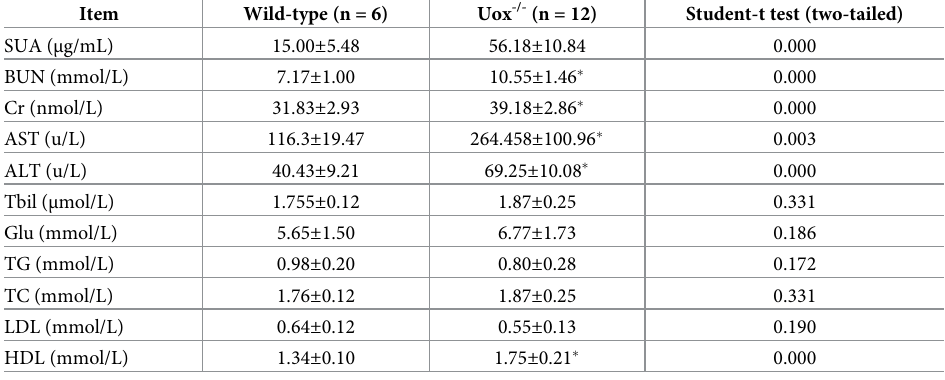
Table 1. Serum indexes associated the kidney and liver function in rats at the age of 45 days were assayed (mean ± SD, n =